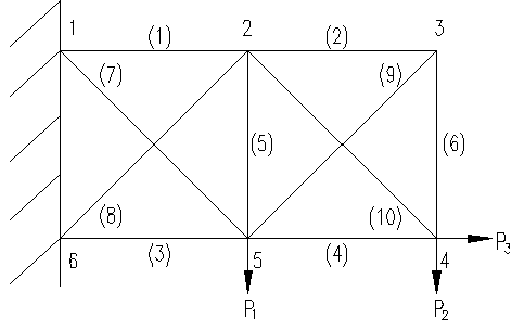
Figure 6. Diagram of Example 4. Table 6. Distribution information of the random variables of the truss structure.